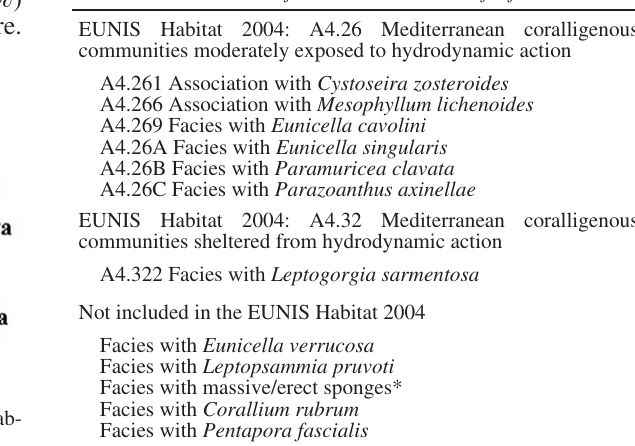
Table 2. – Population units identified in coralligenous assemblages of Liguria. *massive/erect sponges includes Spongia lamella, Sar- cotragus foetidus, Scalarispongia scalaris, Axinella polypoides, Chondrosia reniformis and/or Petrosia ficiformis